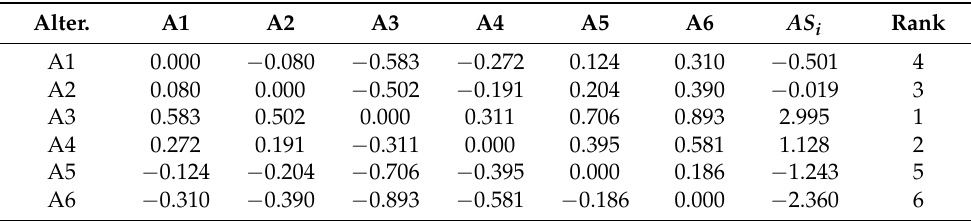
Table 9. Relative assessment